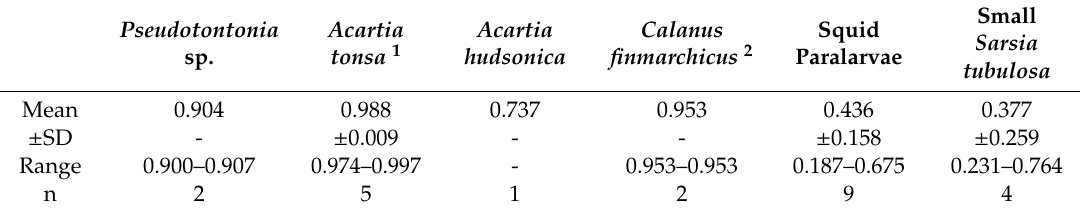
Table 2. Summary of the calculation results of the Froude propulsion e ffi